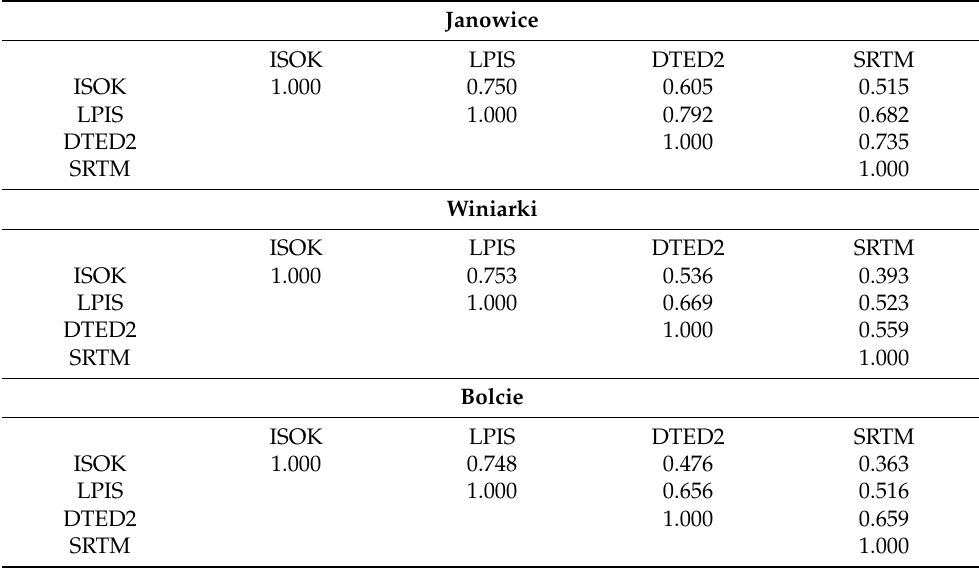
Table 7. Comparison of the Pearson correlation coefficients of the slope values ( ◦ ) calculated on the basis of the 4 sources of DTMs in the 3 research areas.